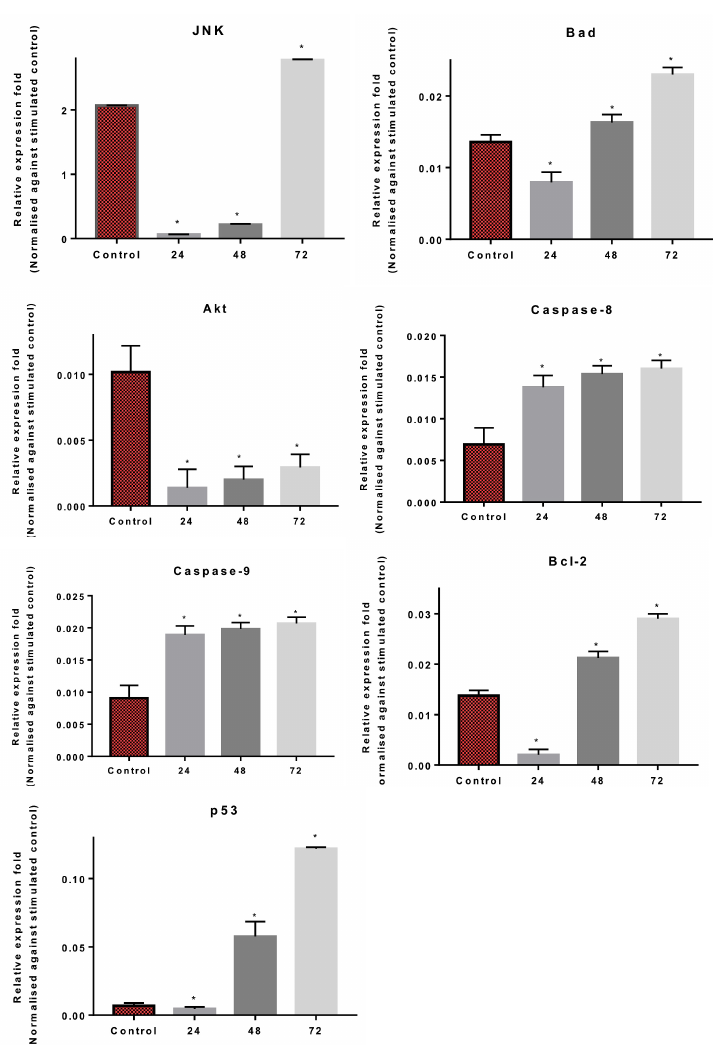
Figure 9. Expression level of apoptosis-related proteins in PC-3 cells treated with GMG-ITC as determined by multiplex analysis. The data are represented as relative expression of proteins in mean ± SD of at least three replicates from three independent tests. An asterisk * indicates statistically significant different from the untreated control ( p < 0.05).